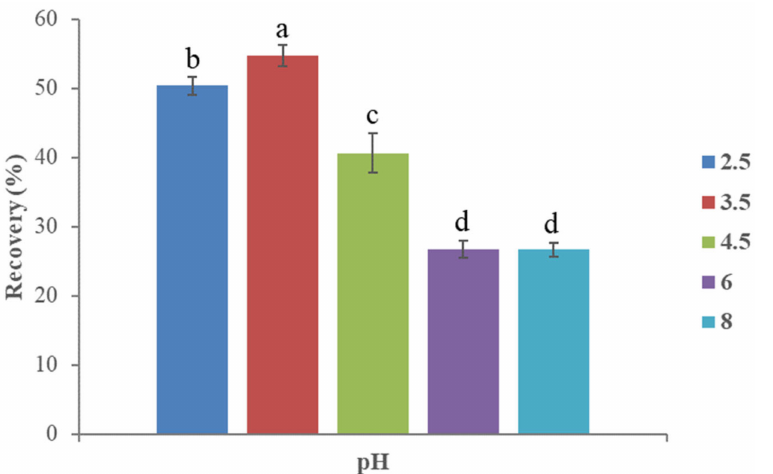
Figure 2. Effect of sample pH on the extraction recovery of carotenoids from LTW; standard deviation of three replicate analyses, is presented with error bars, different letters (i.e., a–d) denote samples that differ significantly (statistical difference for p <